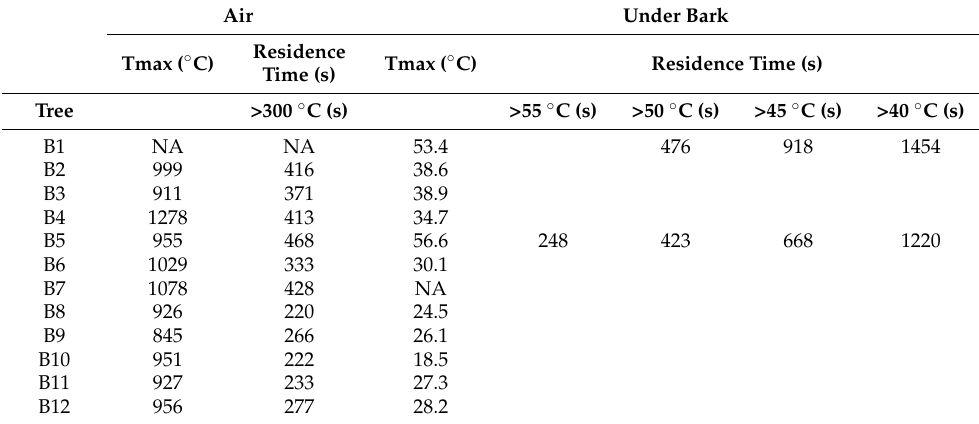
Table 6. Maximum temperature measured outside the trunk (air) and under the bark and residence time above thresholds. Temperature thresholds were determined from